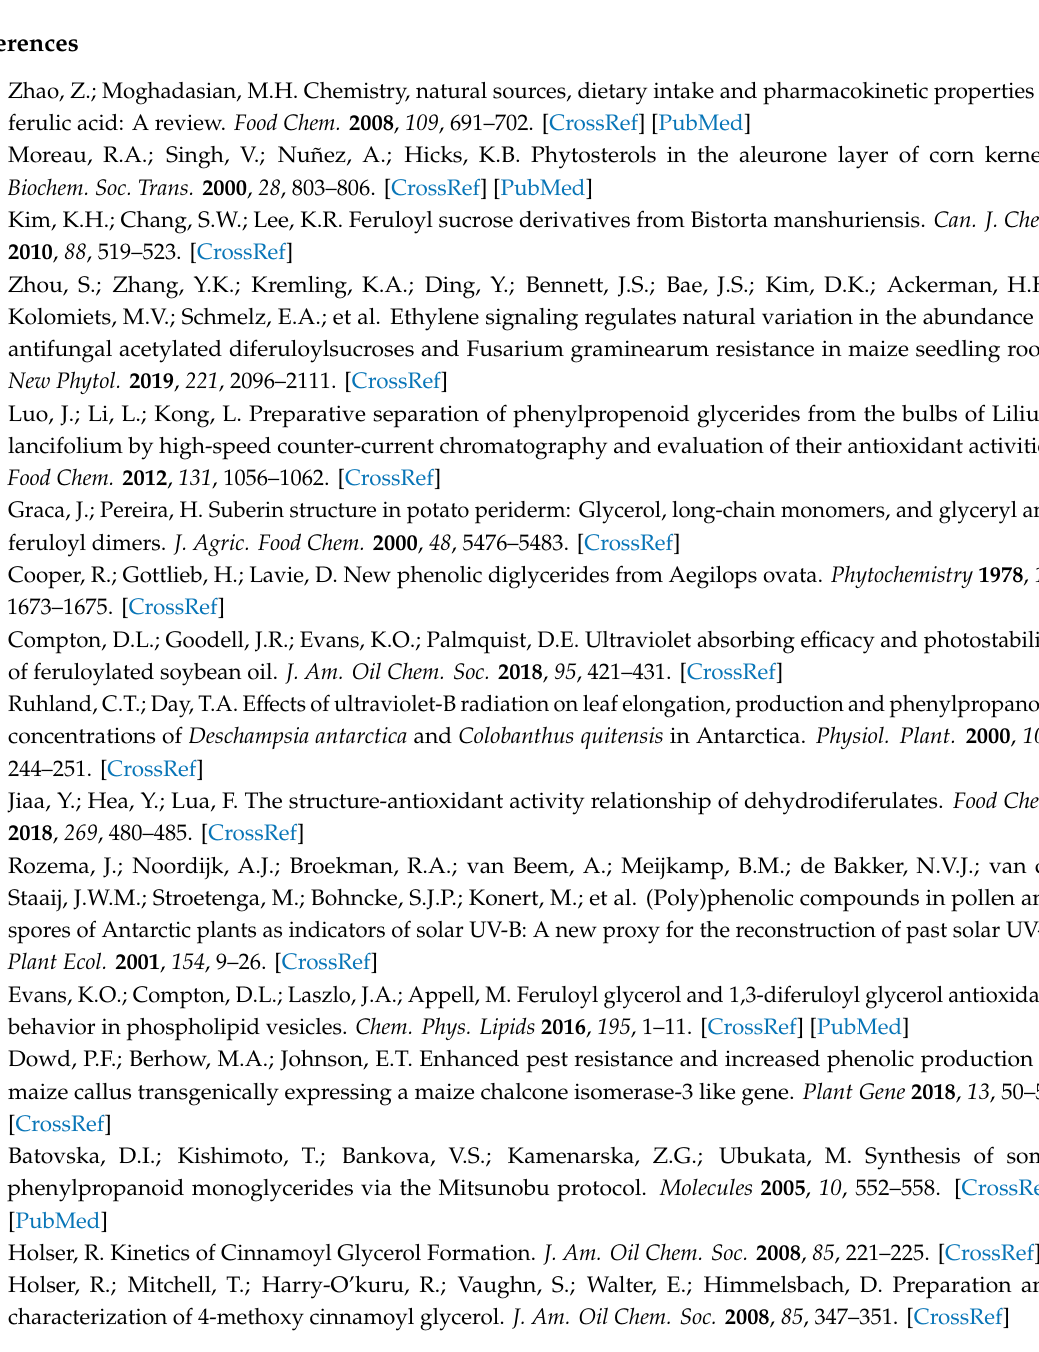
Figure S5: Chemical structures of the commercial UV-absorbing ingredients, Figure S6: Absorbance extinction coe ffi cient ( ε , M − 1 cm − 1 ) of FG and F 2 G in ethanol, and Figure S7: Absorbance extinction coe ffi cient ( ε , M − 1 cm − 1 ) of FG and F 2 G in